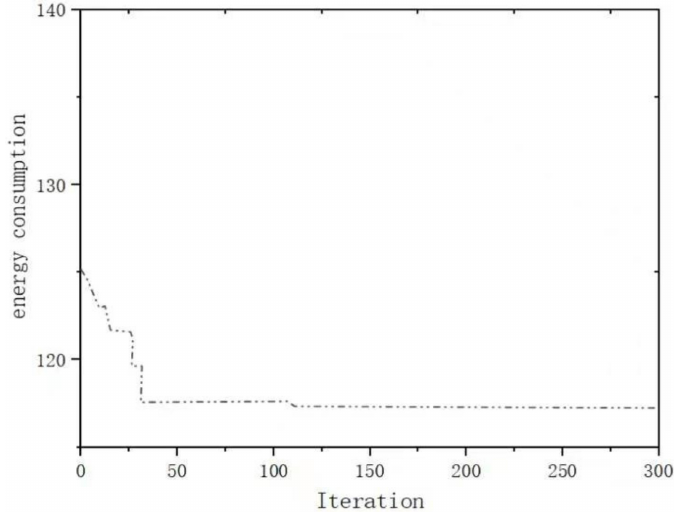
Figure 5. Energy consumption iterative convergence graph for blank dimension 1.